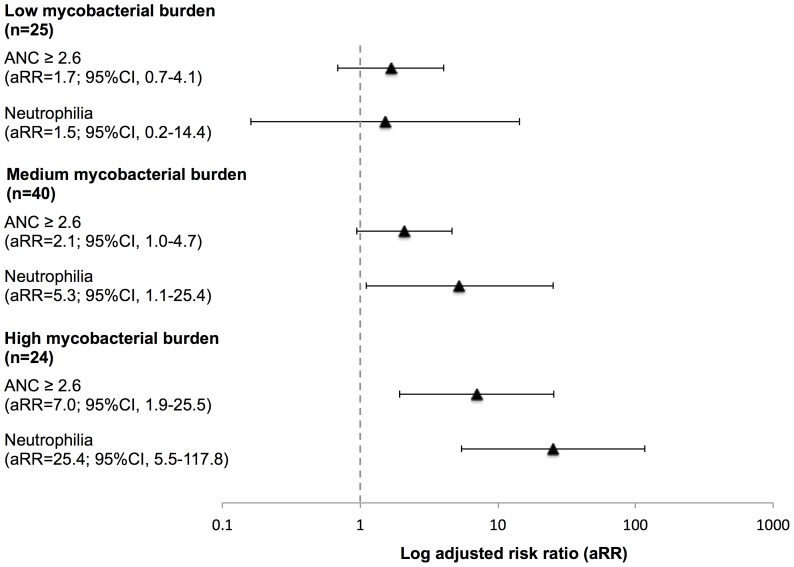
Log adjusted risk ratios (aRR) for increased blood neutrophil counts stratified by low (n = 25), intermediate (n = 40) and high (n = 24) sputum mycobacterial load.